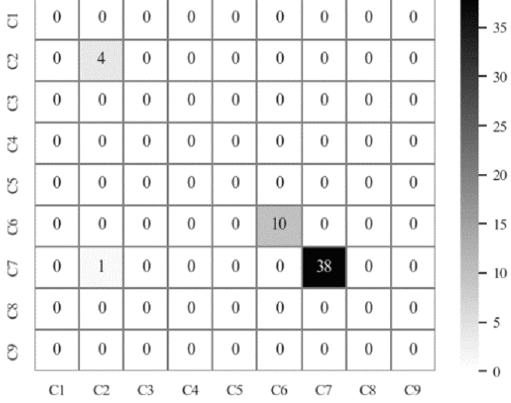
Figure 9. Confusion matrix for measured data recognition